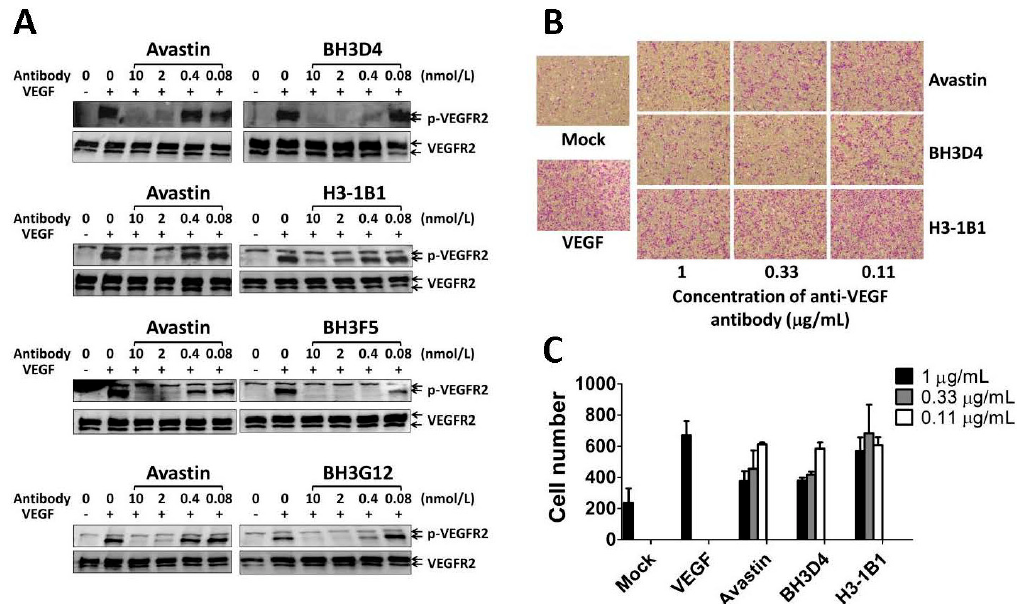
Figure 3. Inhibition of VEGF-induced cell migration. ( A ) Inhibition of VEGF-induced VEGFR2 phosphorylation. HUVECs were starved and treated with VEGF and test antibodies. Cell lysates were electrophoresed and analyzed by Western blot with anti-VEGFR2 and anti-phospho-VEGFR2 (Tyr1175) antibody; ( B ) The migration activity of HUVECs was evaluated using a Transwell assay system. Cells were added onto the top chamber, whereas migration stimuli VEGF mixed with various concentrations of the test antibodies were added to the lower chamber. After 22 h of incubation, the cells on the lower face of the membrane were stained and counted under microscope at 100× magnification; ( C ) The cell counts were obtained from three random fields and presented as mean ± SD.